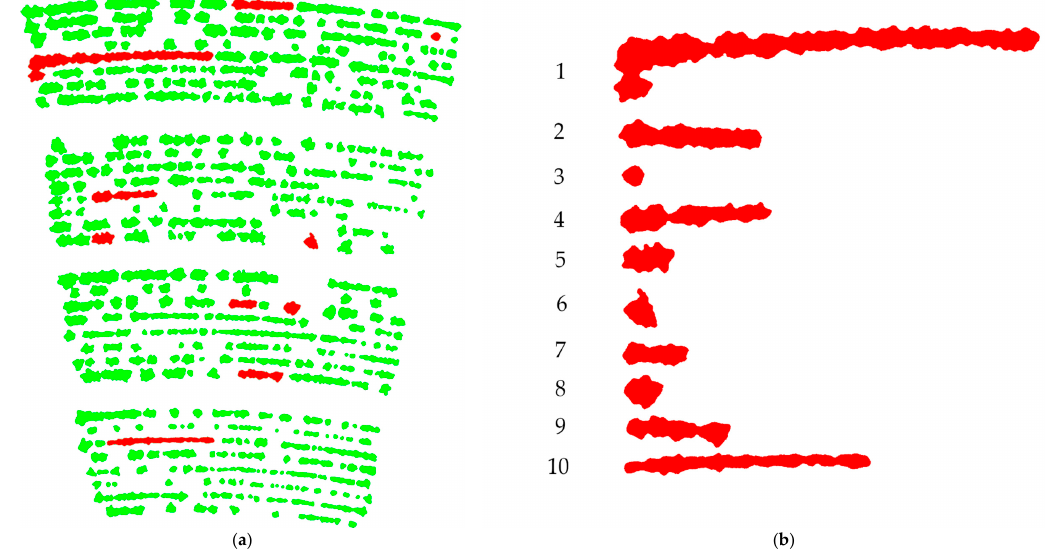
Figure 5. Panel ( a ), subset of binary large object-based areas of measurement (BLOB-based AOMs) selected for data extraction from plot 2. BLOBs were chosen to represent a variety in terms of size and distribution within the plot. Panel ( b ), shows the BLOBs for comparative purposes.